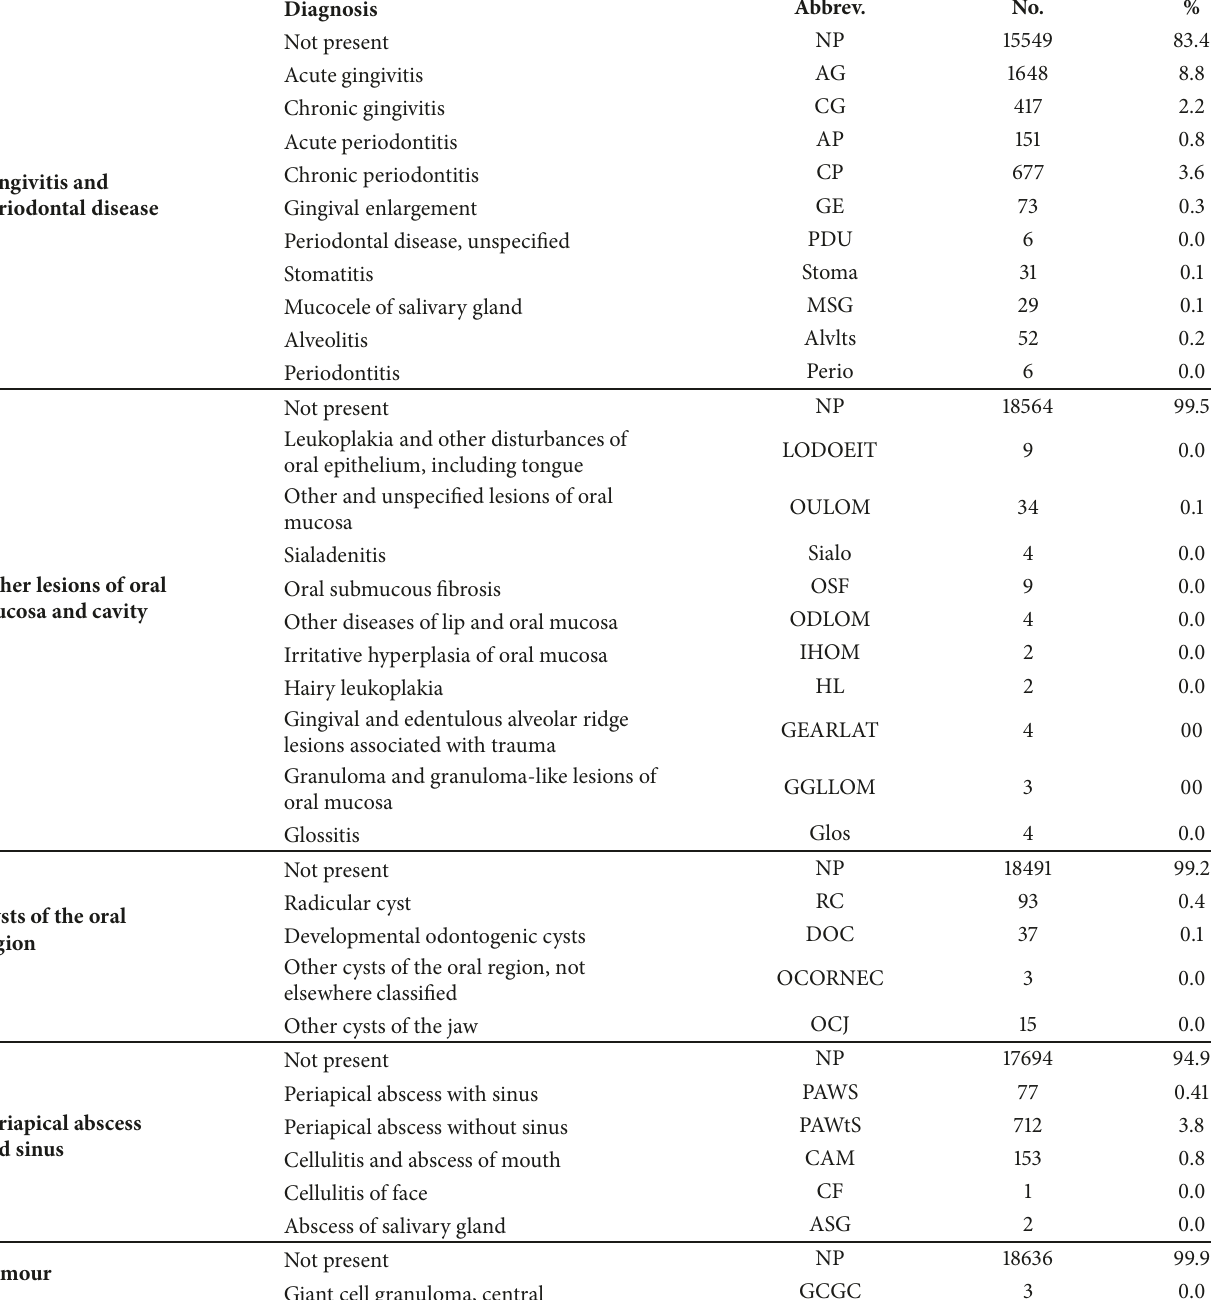
Table 3: Classification and distribution of oral pathologies (soft